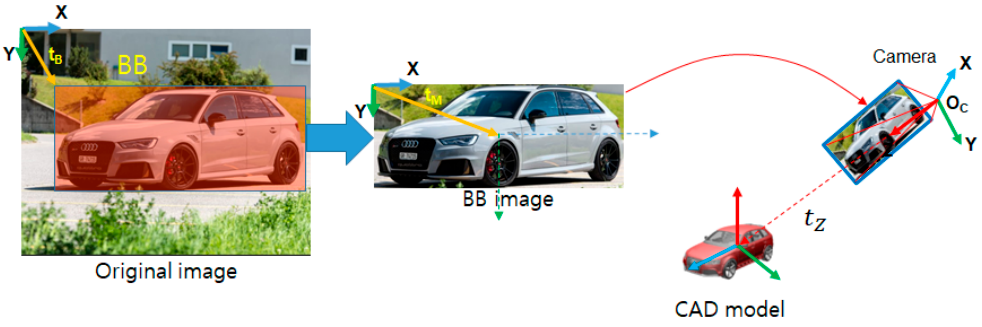
Figure 4. Definition of the translation ‘t z ’ from the camera to the CAD model